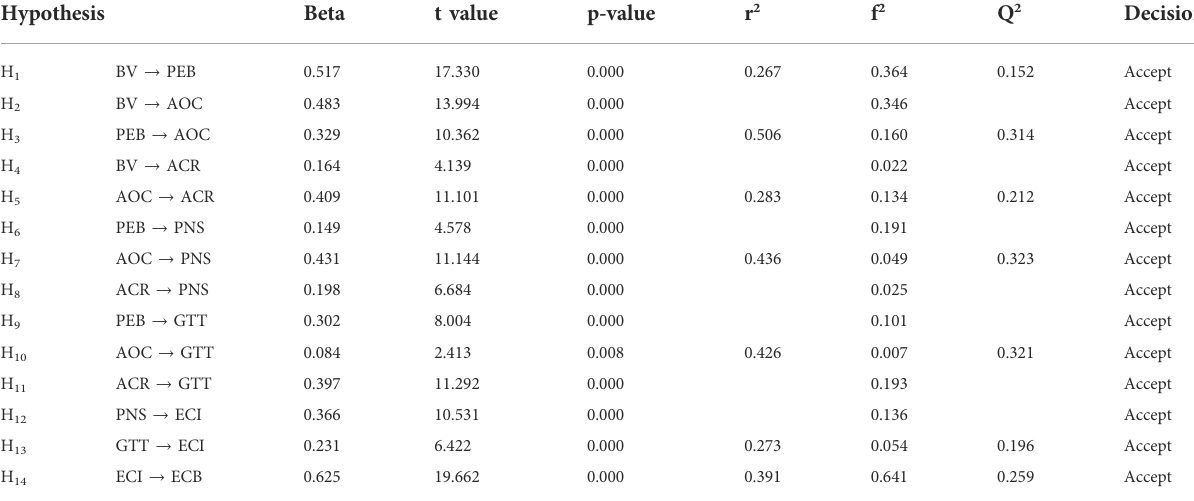
TABLE 5 Hypothesis testing.